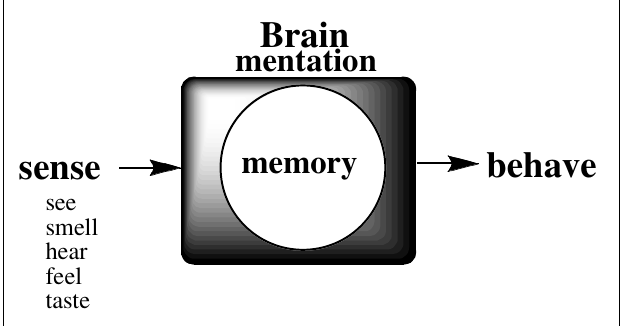
FIGURE 1 | Schematic of the process whereby an external stimulus is remembered to determine whole body response, critical for survival.